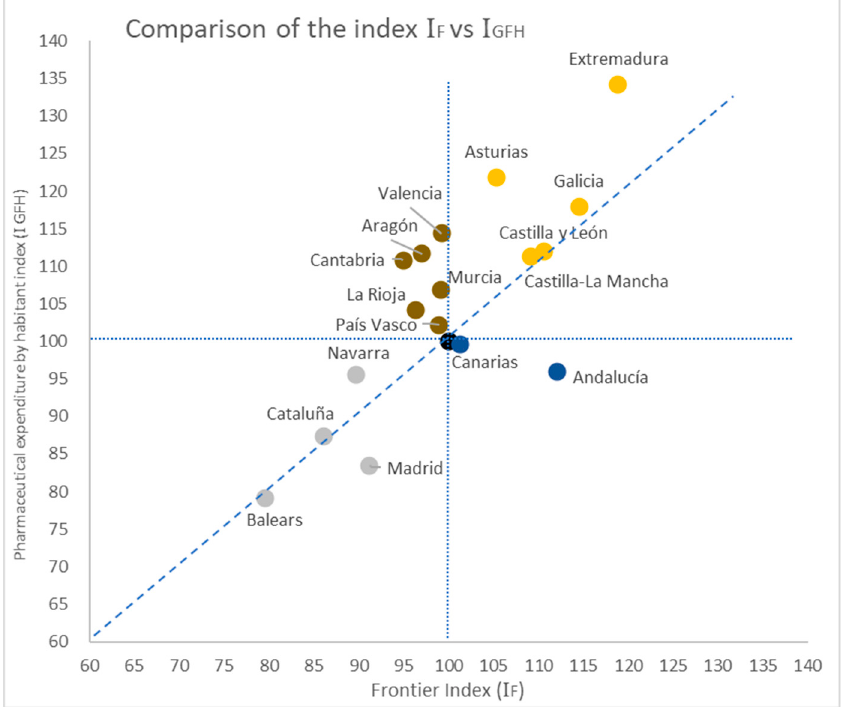
Figure 3. Comparison of the index IF vs. IGFH.